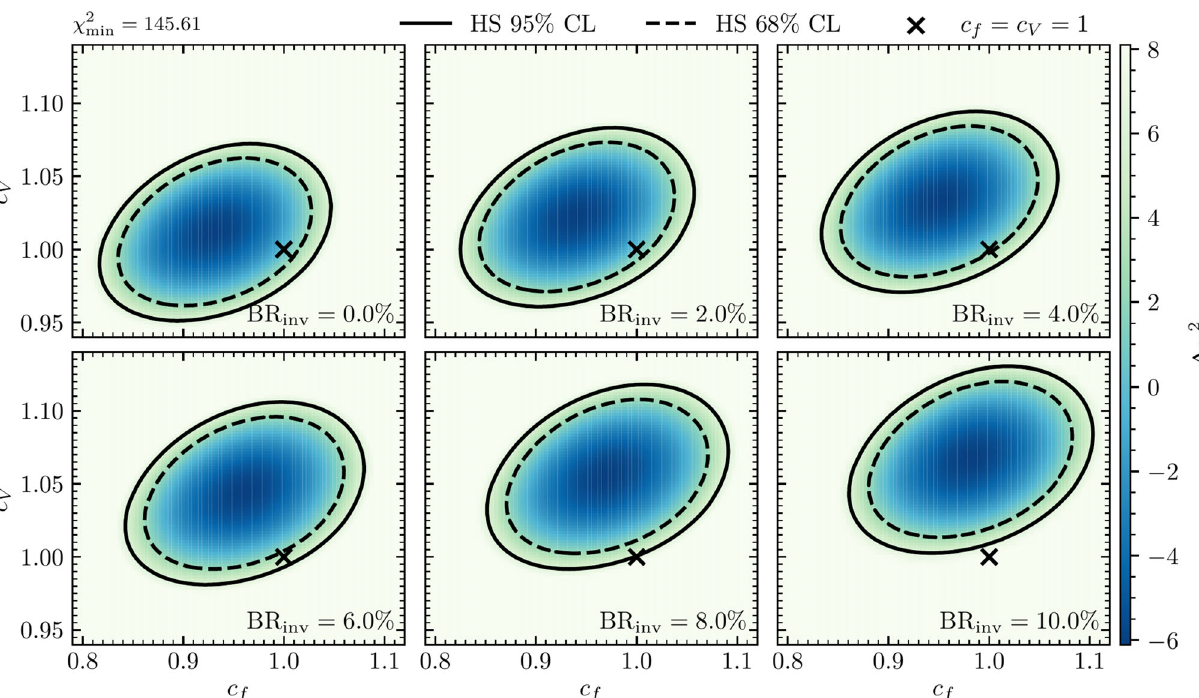
Fig. 3 Result of the global fit to the Higgs-boson signal-rate measure- ments in the plane { c f , c V } for different values of BR inv . The color coding indicates the value of (cid:10)χ 2 resulting from the HiggsSignals analysis. The black solid and dashed lines indicate the allowed regions